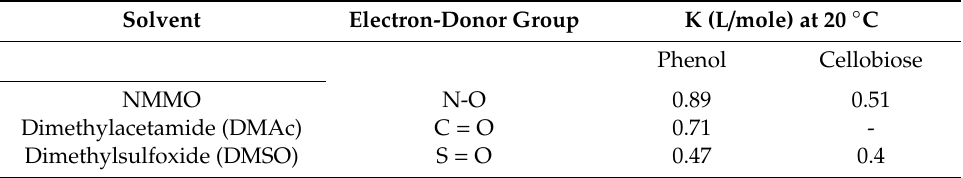
Table 1. Complexation constant K of donor solvents with phenol and cellobiose in